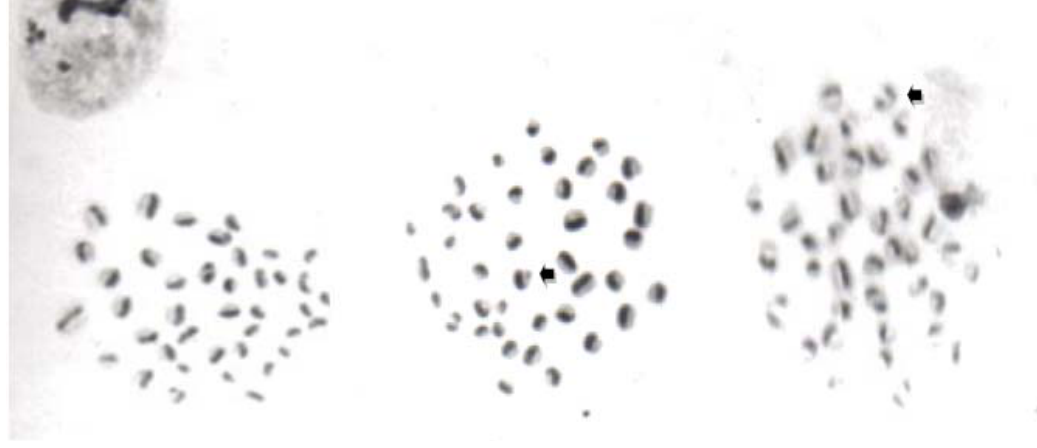
Figure 1. Chromatid differential staining to observe sister chromatid exchange (SCE) in spermatogonial cells. Examples of SCE are indicated by the